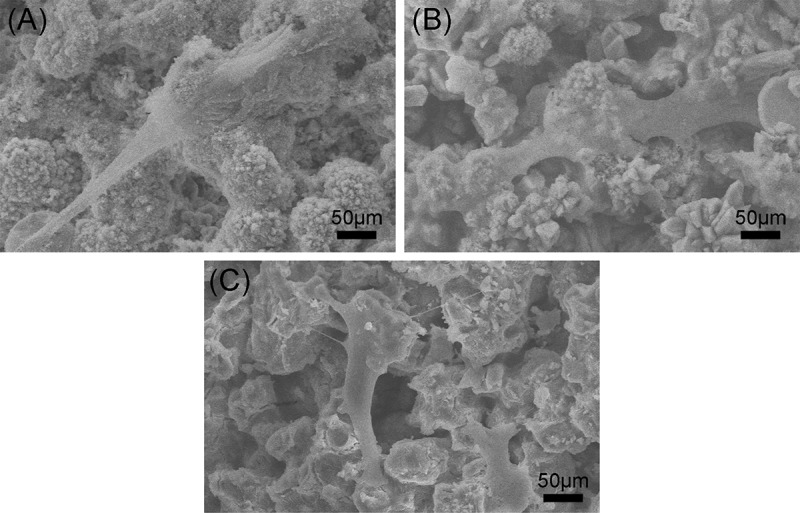
SEM images of the attachment of rBMSCs on β-Ca2SiO4 scaffolds sintered at (A) 1000 °C, (B) 1100 °C, and (C) 1200 °C after cell culture for 3 days.